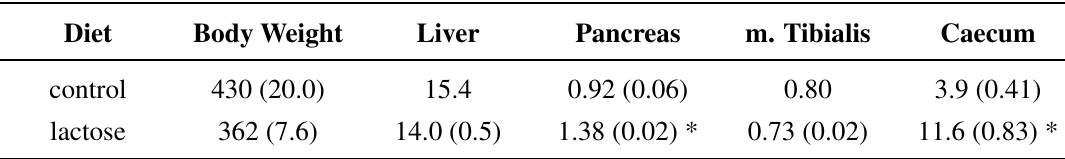
Table 1. Body weight and organ weight (in g) of male rats at autopsy on postnatal (PN) Day 98. Data are means (SEM) n = 1–2 for controls and n = 3 for the lactose diet group. * p < 0.05.